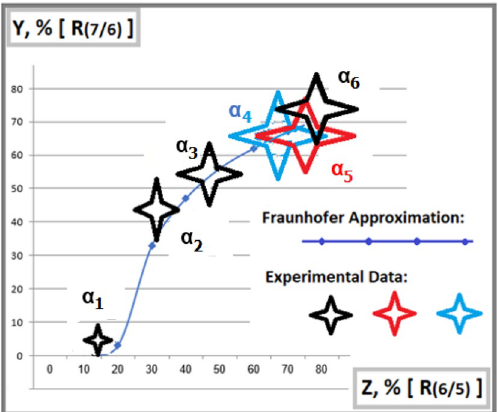
I ( 7 )/ I ( 6 ) with another Experimental ratio =